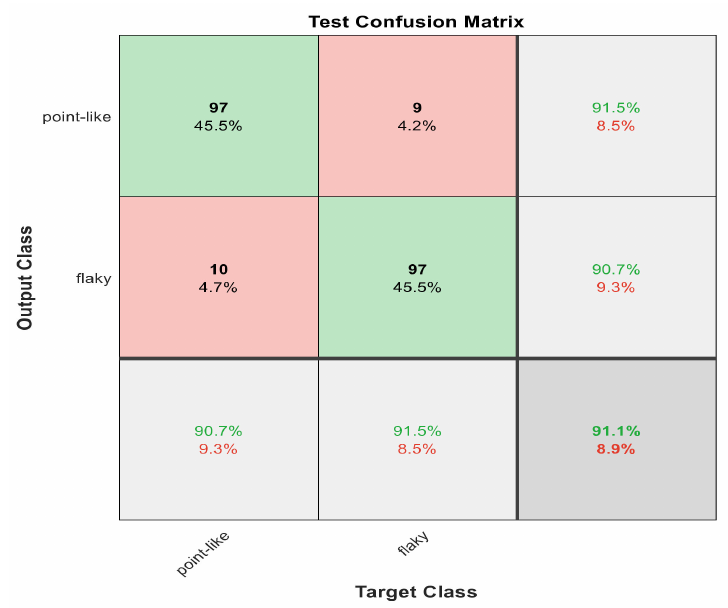
Figure 8. The confusion matrix with ECFS-reduced features for Model 1.